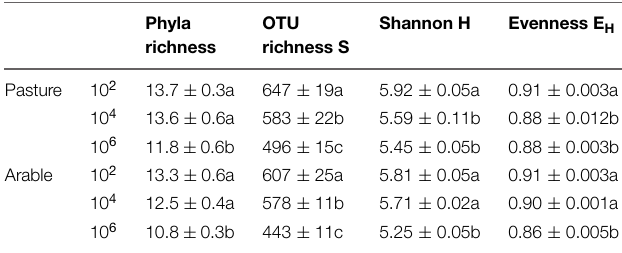
10 2 Pasture n = 18, P < 0.045, Arable n = 12, P < 0.008).